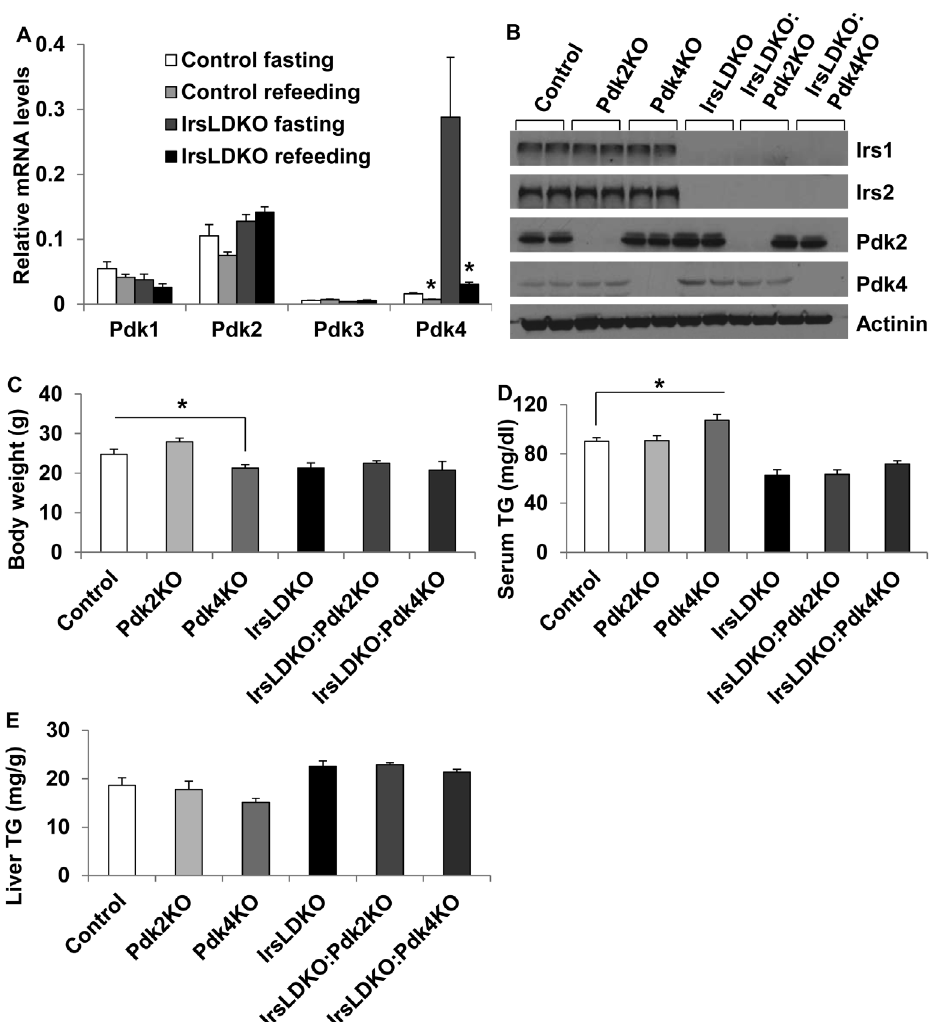
Figure 1. Knockout of the Pdk genes in wild-type and IrsLDKO mice. A, Control wild-type and IrsLDKO mice (n=3) were fasted overnight for 16 hours and half of them were fed for 4 hours immediately after the fasting. Pdks gene expression in the liver was analyzed by real-time PCR and data were normalized to an internal control gene — Ppia. B, Western blot analysis of liver lysates from control and knockout mice. C, Body weight measurements in control and knockout mice (n=6–20). D, Serum triglycerides (TG) were measured in overnight fasted control and knockout mice (n=6–8). E, Liver TG analysis in control and knockout mice (n=6–8). Pdk2KO, Pdk2 knockout; Pdk4KO, Pdk4 knockout; IrsLDKO, Irs1/2 liver-specific double knockout. Data are presented as means 6 SEM. *, P , 0.05 relative to corresponding